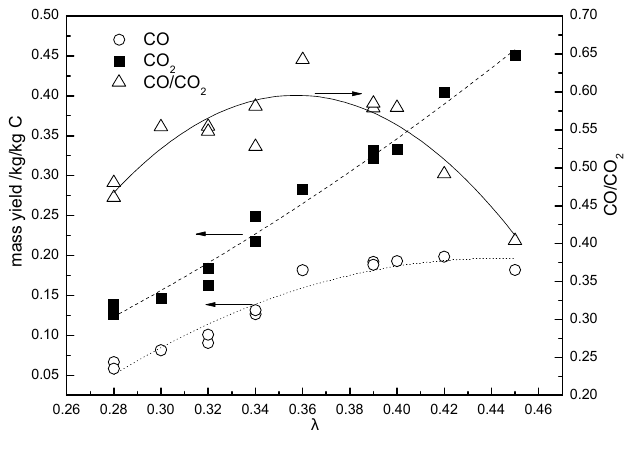
Figure 7. CO and CO 2 mass yield.